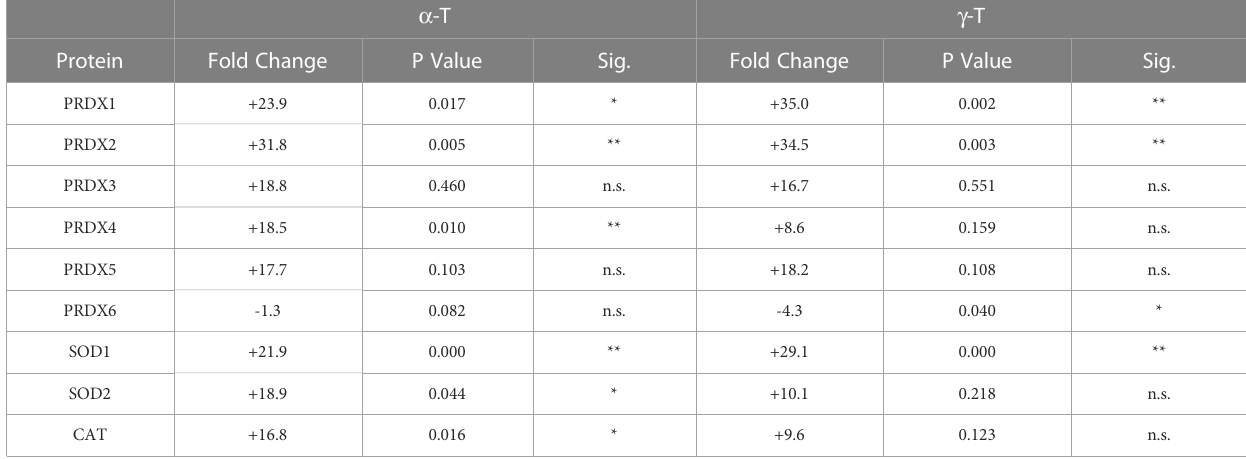
TABLE 5 The effect of a T and g T on the expression of Per-oxidases, SOD and CAT. a -T g -T Sig.